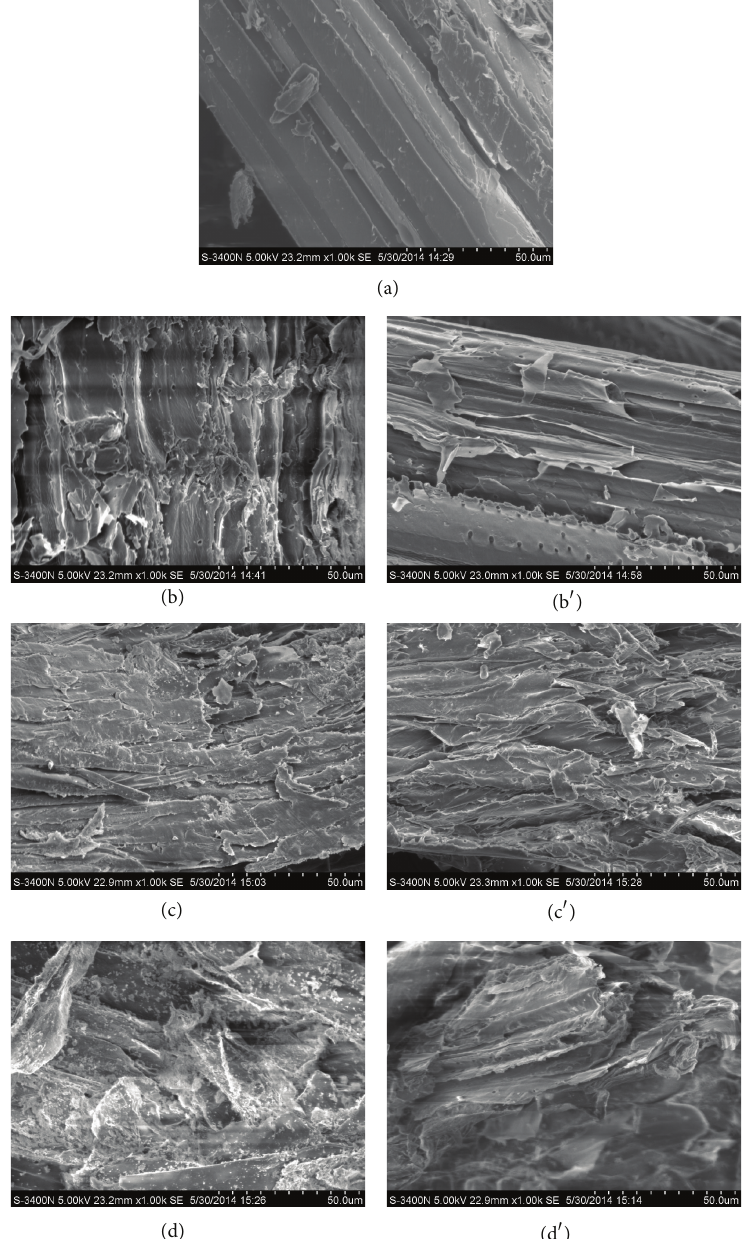
Figure 3: SEM analysis of corn stalk and cellulose-rich materials. (a) Untreated corn stalk; (b) [BMIM]Cl/DMSO; (c) [HMIM]Cl; (d) [HSO 3 - pMIM]Cl; (b 󸀠 ) [BMIM]Cl/DMSO/H 2 O; (c 󸀠 ) [HMIM]Cl/H 2 O; (d 󸀠 ) [HSO 3 -pMIM]Cl/H 2